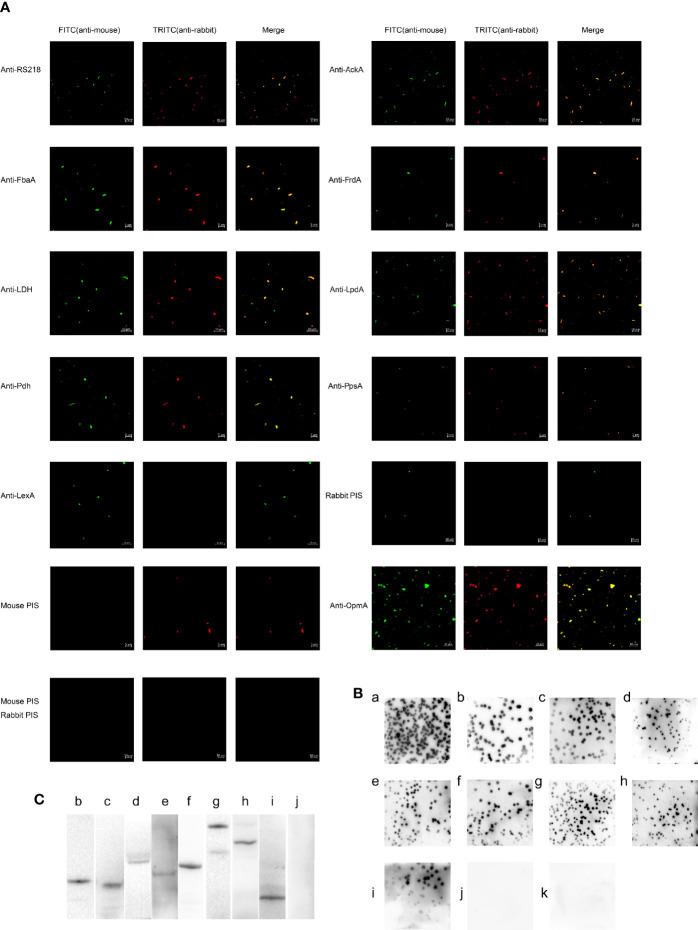
The outer membrane localization of CMEs on ExPEC. (A) Immunofluorescence of ExPEC strain treated with the mixture of mouse anti-RS218 anti-serum and rabbit anti-RS218 anti-serum (positive control) or rabbit anti-OmpA antibody (out membrane protein control) or rabbit anti-CME antibody or rabbit anti-LexA antibody. The mixture of mouse anti-RS218 anti-serum and rabbit PIS, the mixture of rabbit anti-RS218 anti-serum and mouse PIS, and the mixture of mouse PIS and rabbit PIS was used as negative controls. Detection was conducted by incubating with FITC-conjugated anti-mouse IgG and TRITC-conjugated anti-rabbit IgG. (B) Immunoblotting reaction of ExPEC strain RS218 colonies. Colonies were covered with NC membrane followed by incubation with rabbit anti-RS218 anti-serum (a), anti-CMEs antibodies (b, anti-AckA; c, anti-FbaA; d, anti-FrdA; e, anti-LDH; f, anti-LpdA; g, anti-Pdh; and h, anti-PpsA), anti-OmpA antibody (i); anti-LexA antibody (j), and rabbit PIS (k). (C) The outer membrane proteins were extracted and detected by Western blotting (b, AckA; c, FbaA; d, FrdA; e, LDH; f, LpdA; g, Pdh; h, PpsA, i, OmpA; j, LexA).